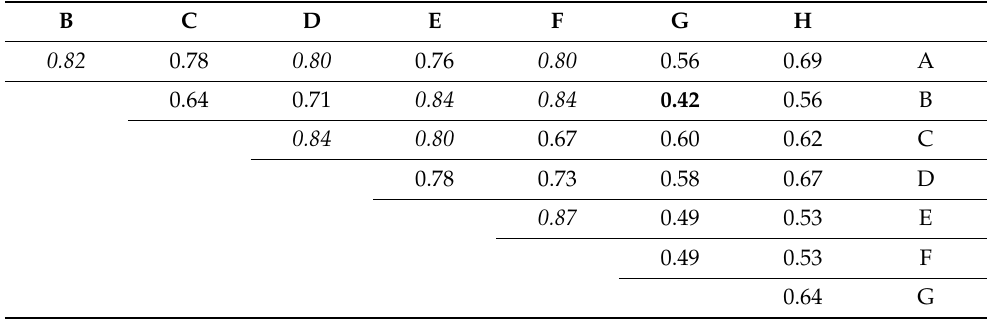
Table 13. Values of % agr